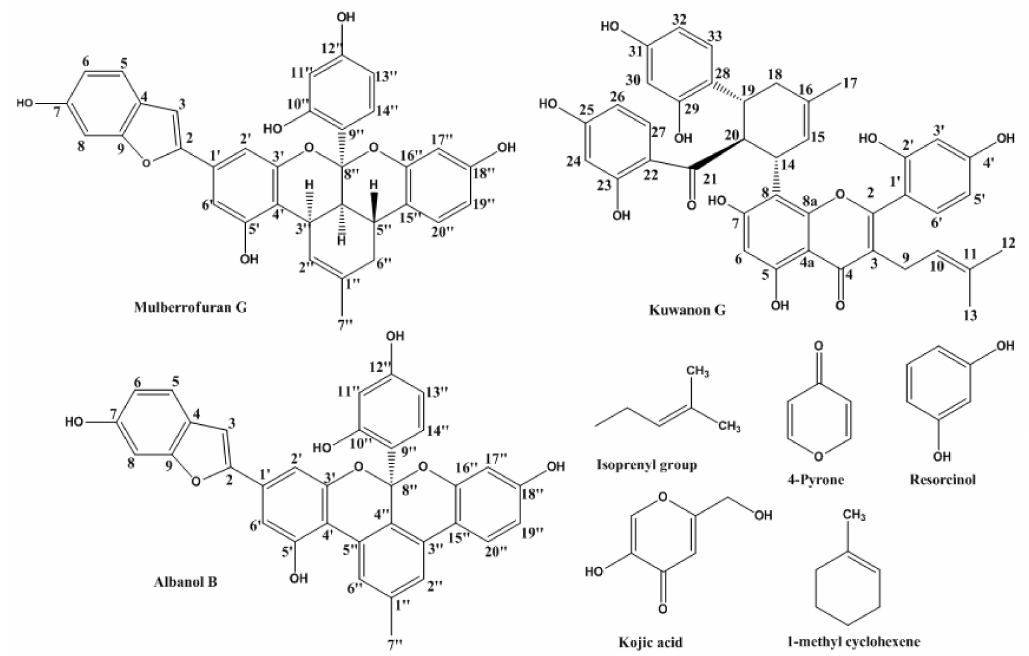
Figure 1. Structure of compounds from Morus species and structural moieties explaining structure- activity relationship.